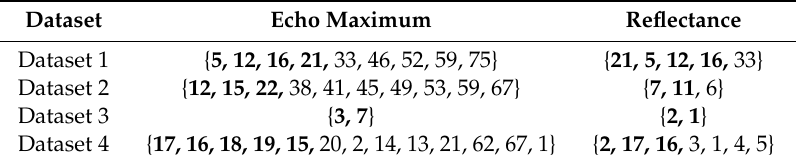
Table 5. The comparison of selected channels.